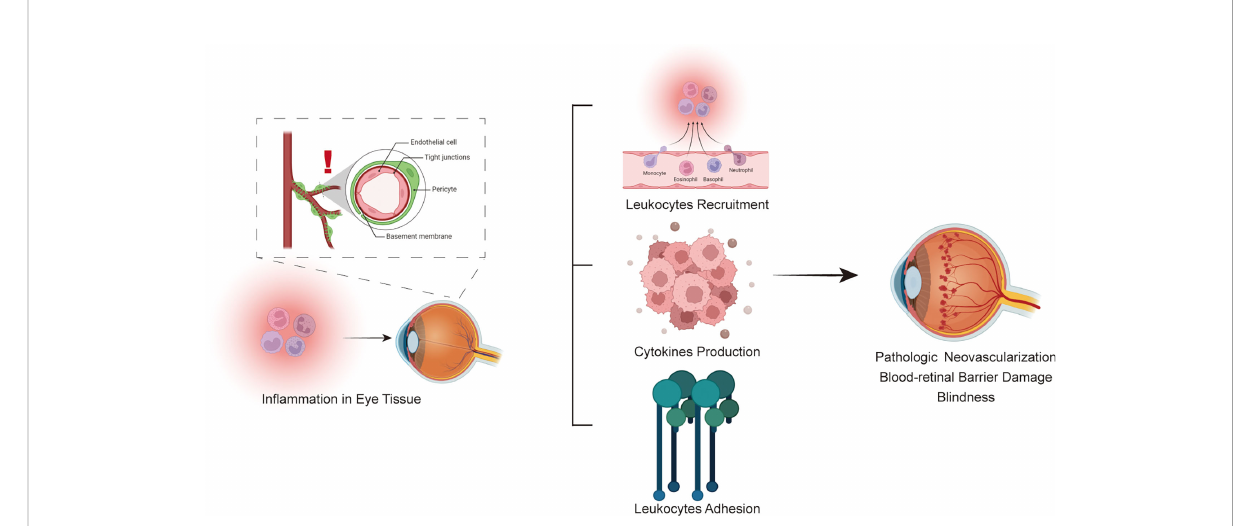
FIGURE 3 Schematic fl owchart for the immune system involved in the pathophysiology of diabetic